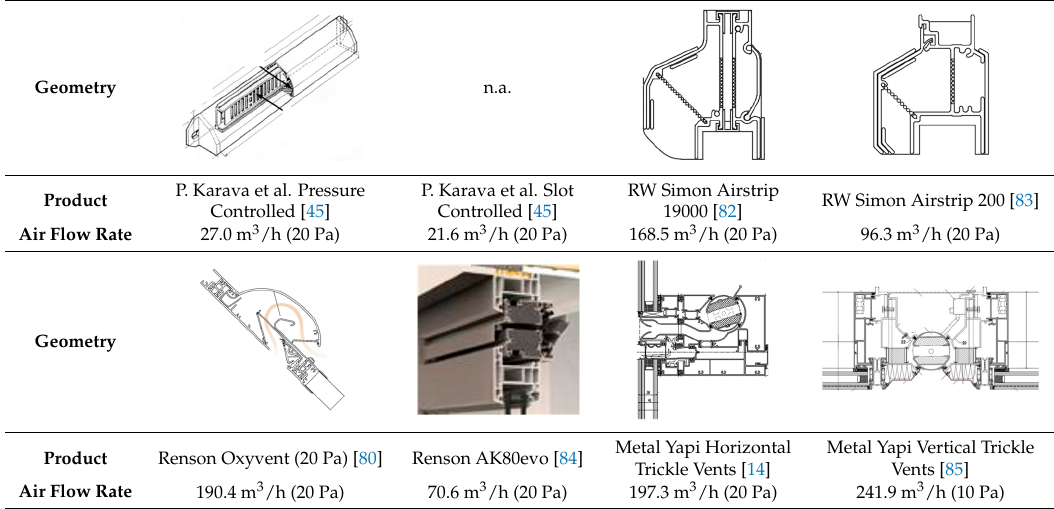
Table 7. Ventilation capacities of randomly chosen various products under various pressure differences for each module in the market.